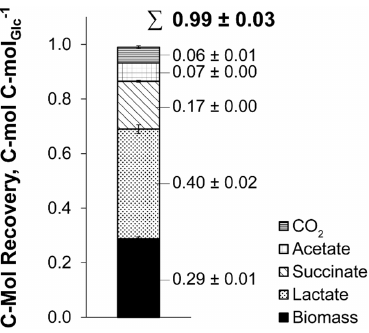
Figure A1. Shaking flask cultivation of C. glutamicum WT in CGXII + 60 g glucose L − 1 . Error bars represent the SD of five independent experiments.